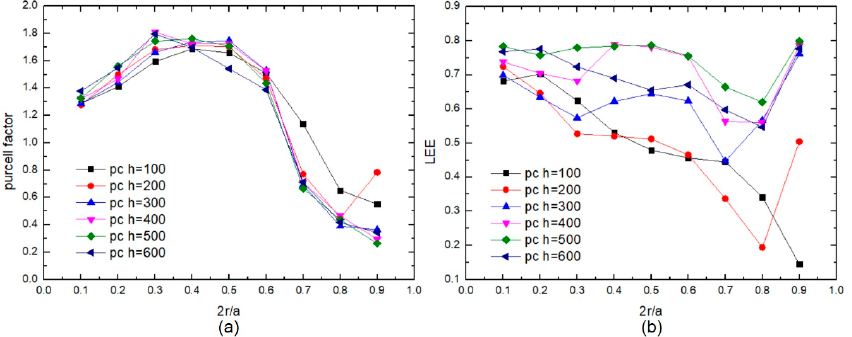
Figure 4. The tendency of ( a ) the Purcell factor and ( b ) LEE changing with the duty cycle and height of the photonic crystals when the photonic crystal period is fixed at 400